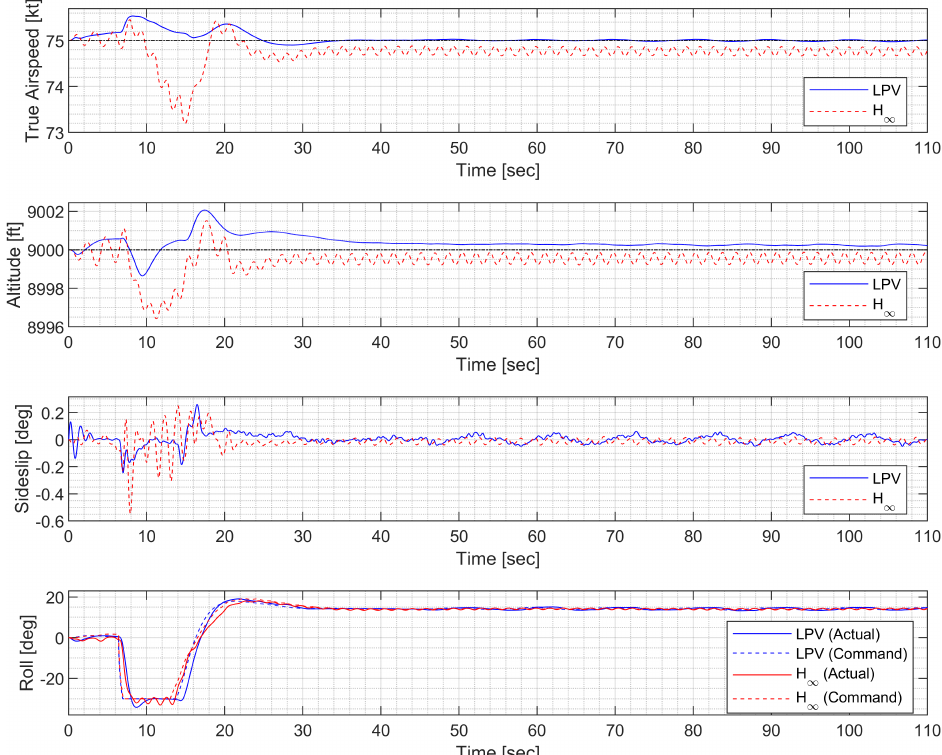
Figure 24. State history of the circular trajectory-following